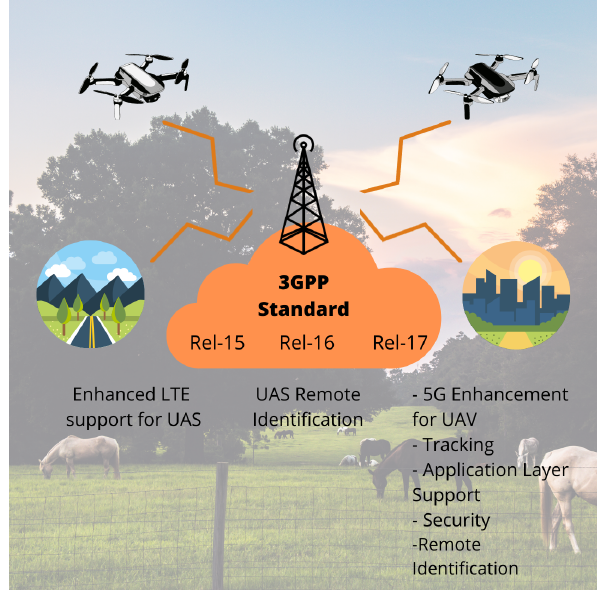
Figure 6. UAS addressing in 3GPP